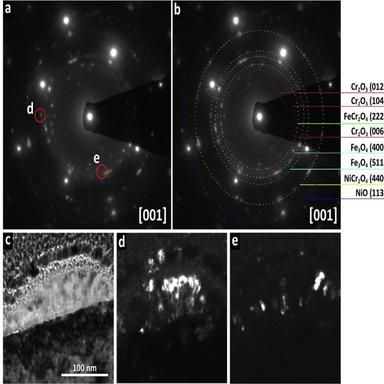
(a) SADP ( zone axis) acquired from the Alloy 600 SA grain boundary and the external oxide layer after exposure to R ¼ 1/24H2-steam environment showing several small reflections associate with the formation of incoherent oxides species on the surface. Several coloured dotted rings highlighting the reflections consistent with the presence of NiO, (Fe,Ni)Cr2O4 and Cr2O3 were added to the SADP in (b). The high spatial resolution BF image (c) showed the morphology of the external oxide layer. The CDF image (d)